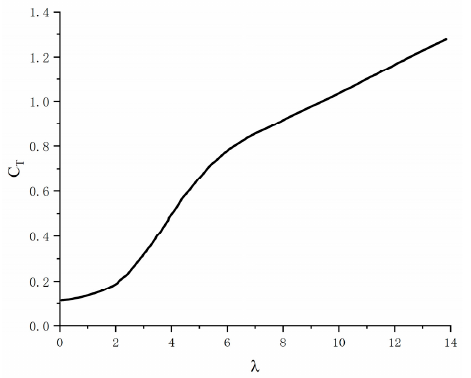
Figure 5. Thrust coefficient C T -tip speed ratio λ s curve